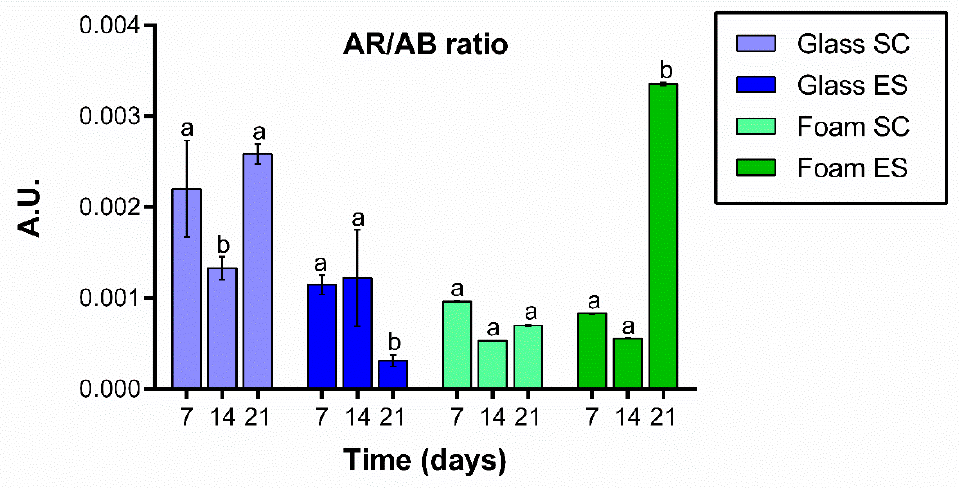
Figure 6. Extracellular matrix mineralization. Calcium deposit quantification of Saos-2 cells grown on glass coverslips or Pd-coated PU foams surfaces under standard conditions (SC) or electrical stimulation (ES) at 7, 14 and 21 days of culture. Different superscripts on top of the columns denote significant differences ( p < 0.05) among different time-points of cells grown on the same materials and under the same conditions.